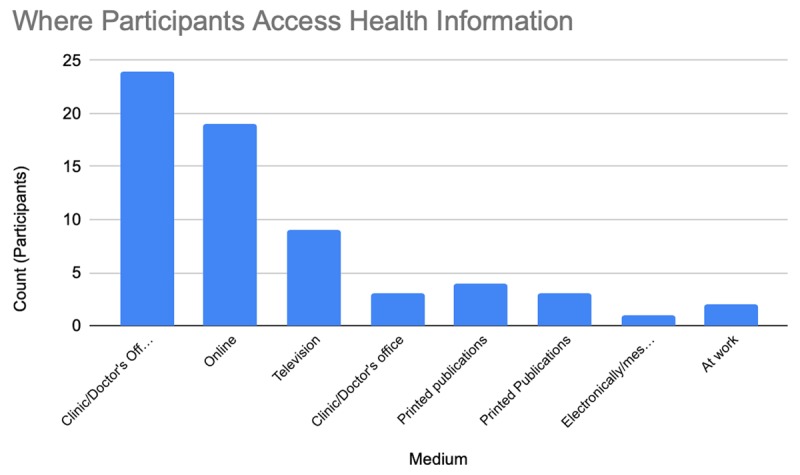
How Participants Access Health Information.